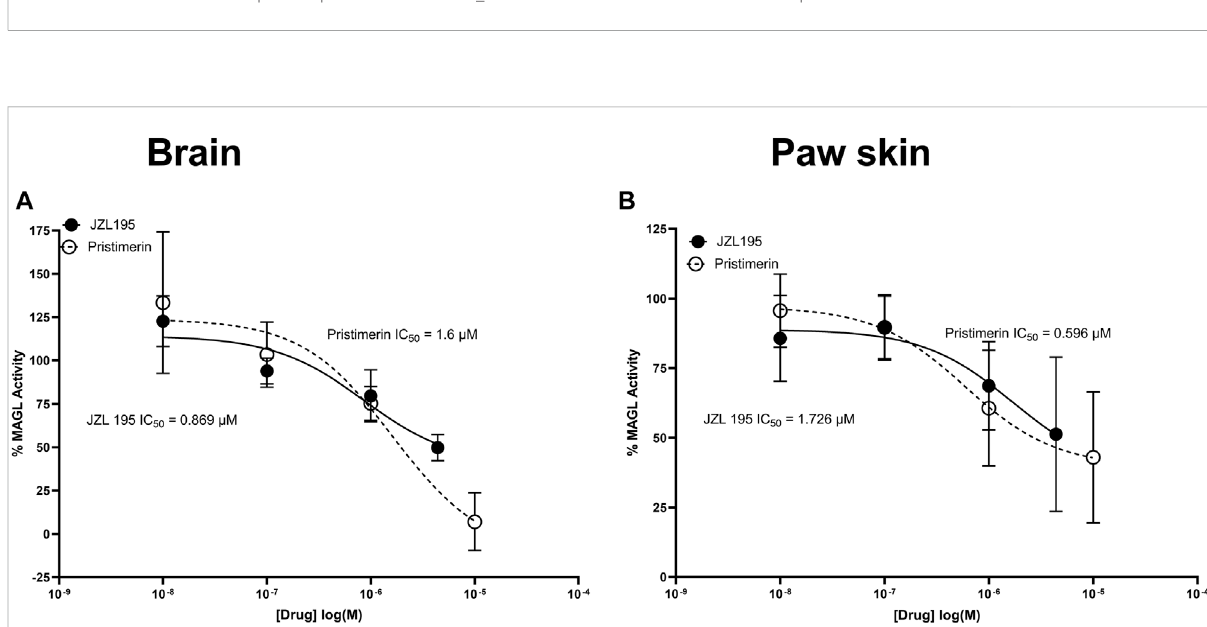
FIGURE 4 InhibitoryeffectsofvariousconcentrationsofpristimerinandJZL195onmouse (A) brainand (B) pawskinMAGLafter10 minofincubation.Each point represents the mean ± SEM of values obtained from 3 experiments from samples pooled from 8